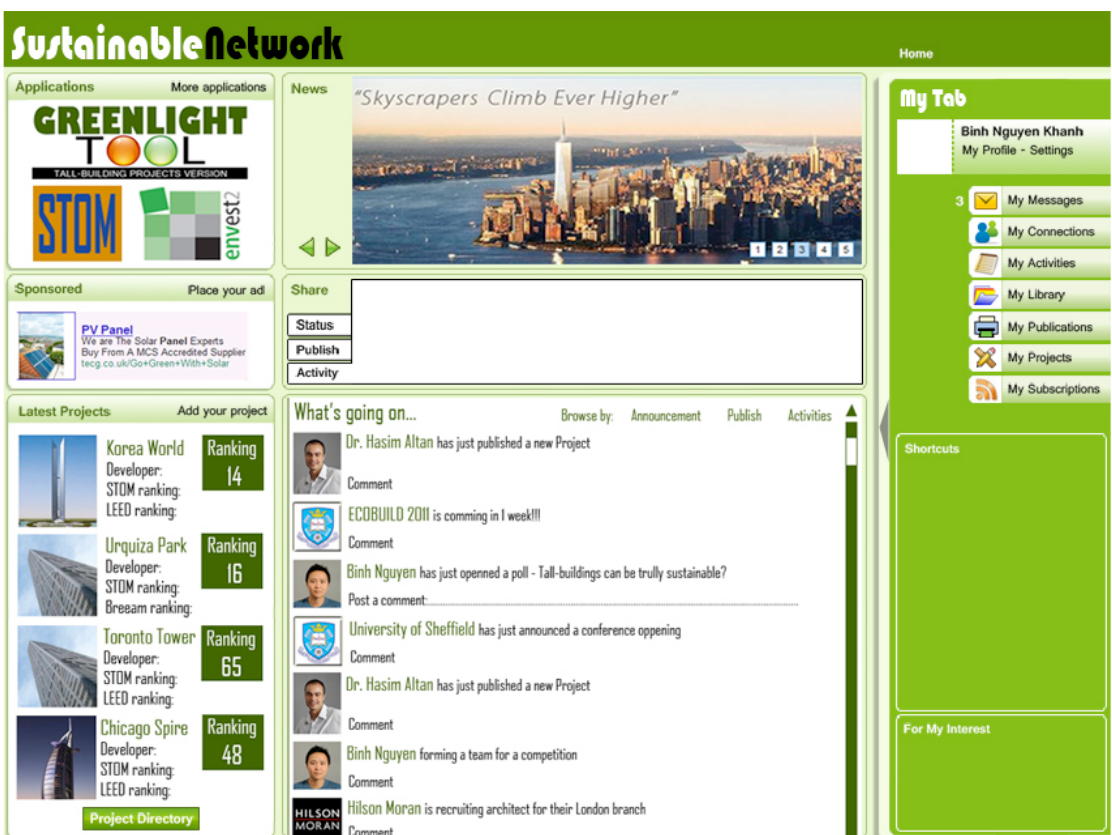
Figure 9. Sustainable